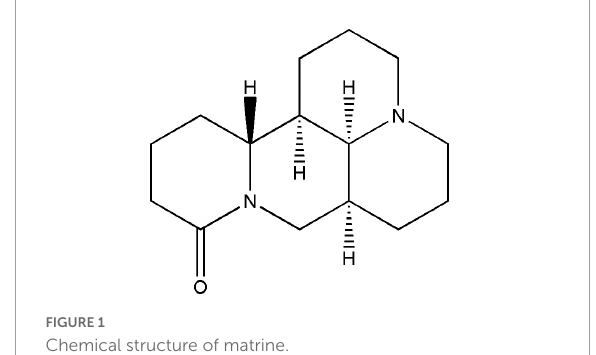
FIGURE1 Chemical structure of